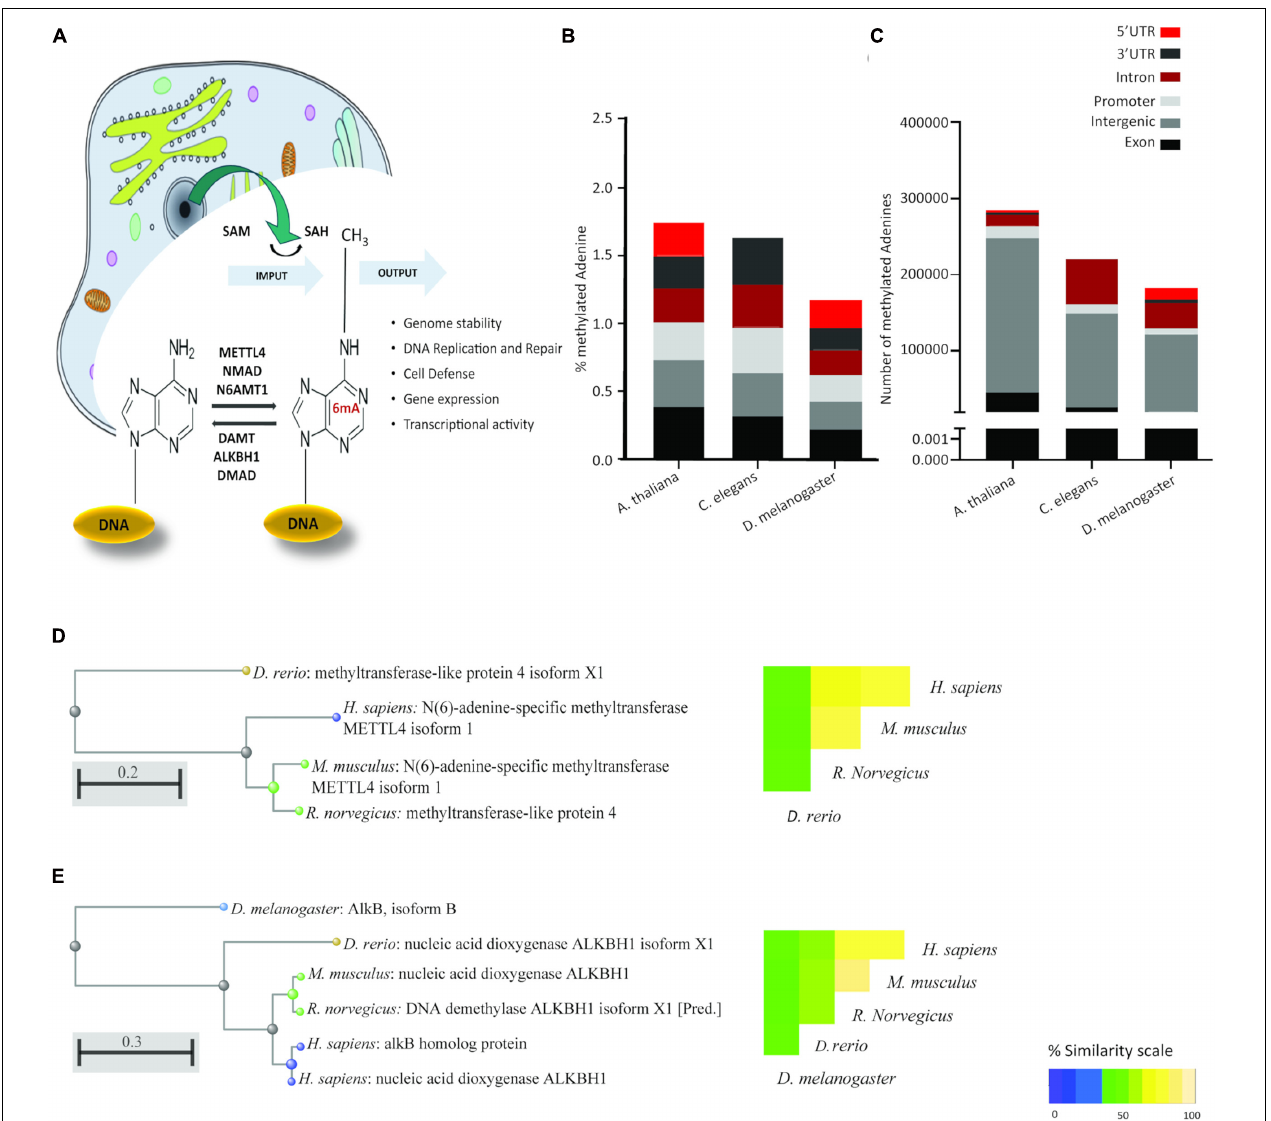
FIGURE 1 | 6mA is a conserved eukaryotic epigenetic modification with conserved epigenetic machinery. (A) Schematic representation of the current knowledge of 6mA. As for 5mC, the methyl group is donated by S-Adenosyl methionine (SAM), leaving S-Adenosyl homocysteine (SAH). Reported methyl transferases include METTL4, NMAD, and N6AMT1. Demethylases include DAMT, ALKBH1 and DMAD. Cellular compartments are not drawn to scale. (B) Relative abundance and (C) absolute abundance of direct-read 6mA calls from three eukaryotic species extracted from the MethSMART database of direct calls from PacBio sequencing, with identifiable eukaryotic sequence surrounding the methylation call. (D) Hierarchical clustering of sequence alignment and percentage sequence similarity for the methyltransferase METTL4. (E) Hierarchical clustering of sequence alignment and percentage sequence similarity for the demethylase